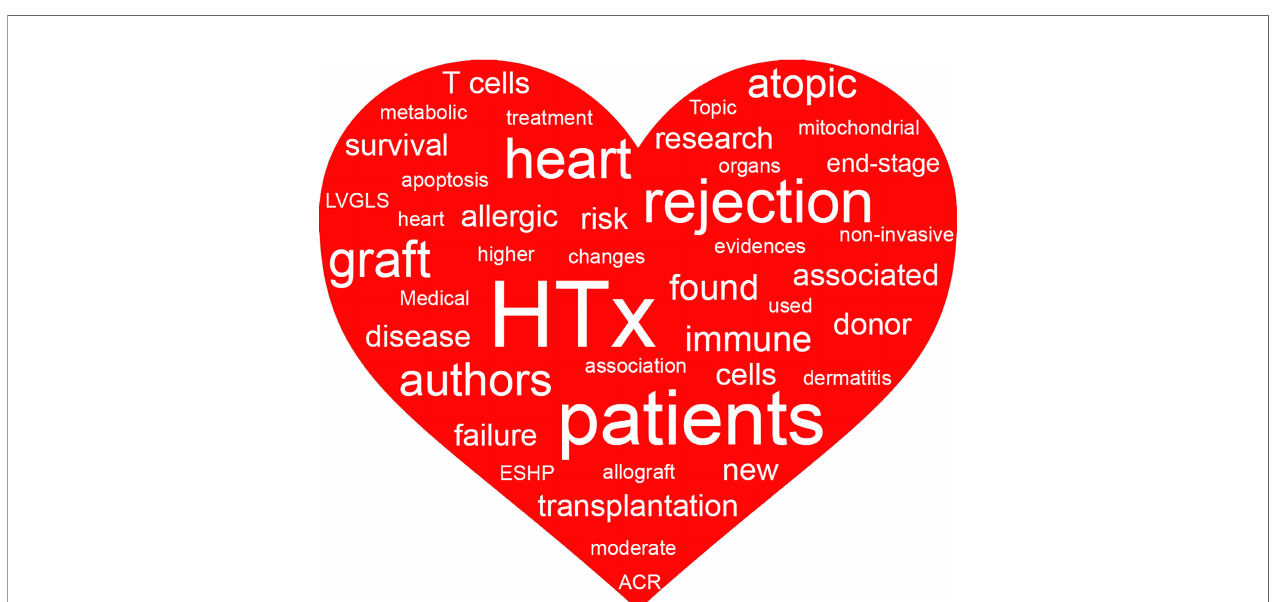
FIGURE 1 | Word cloud of the most frequent terms. This picture describes the most commonly used words in the Editorial on the Research Topic Advances in Heart Transplantation. Note that the size of the words is proportional to their